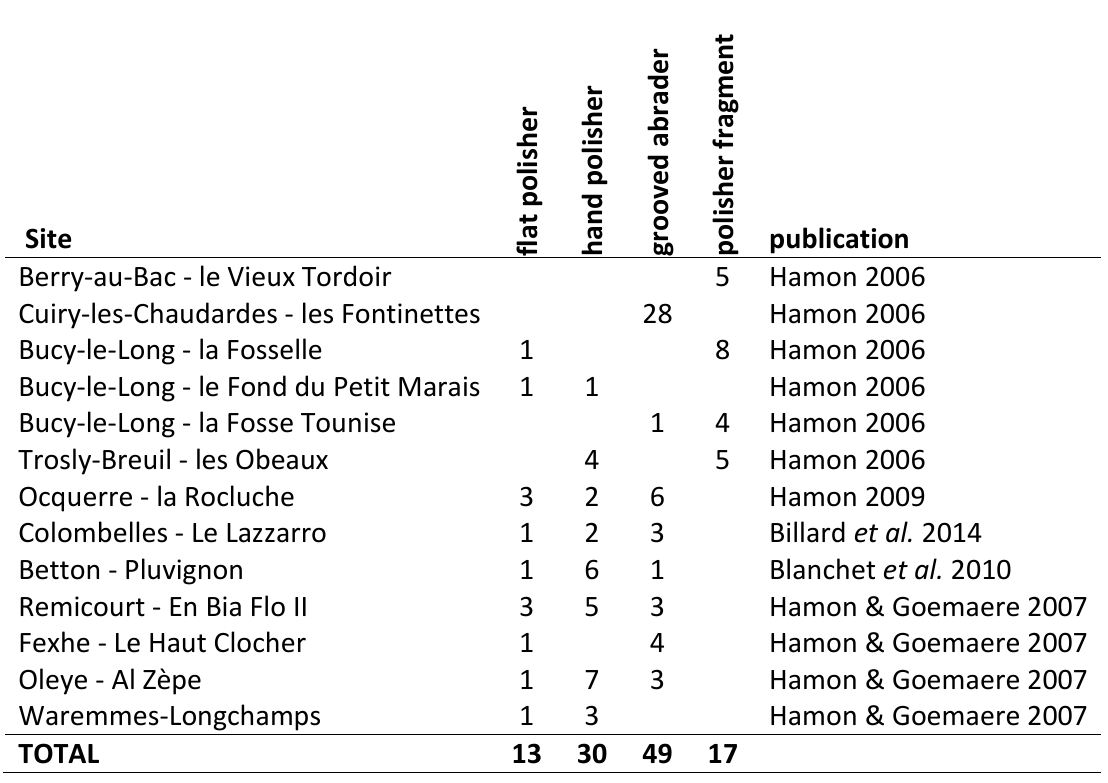
Table 1. Number and types of abraders studied for the early Neolithic of western